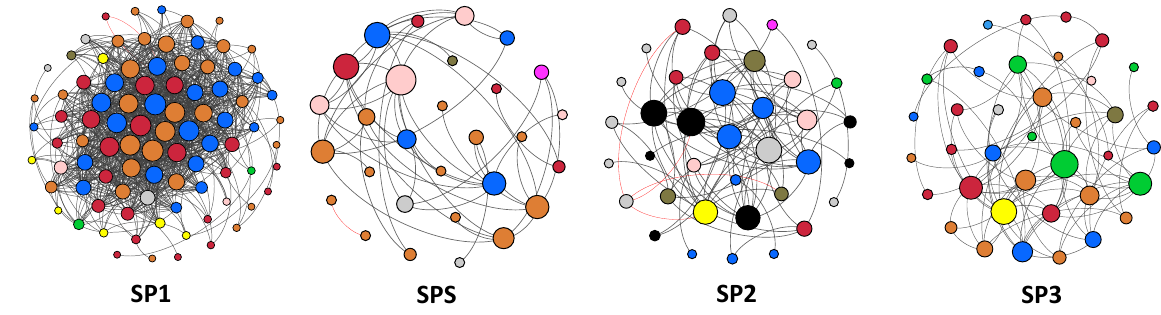
Figure 5. Network co-occurrence analysis of microbial communities from the on-site blackwater treatment system. A connection indicates a SparCC correlation with a magnitude of >0.7 (positive correlation—black edges) or < − 0.7 (negative correlation—red edges) and statistical significance ( p < 0.01). Each node represents a different bacterial genus, and the size of the node is proportional to the number of connections (degree). Each node is labelled at the phylum